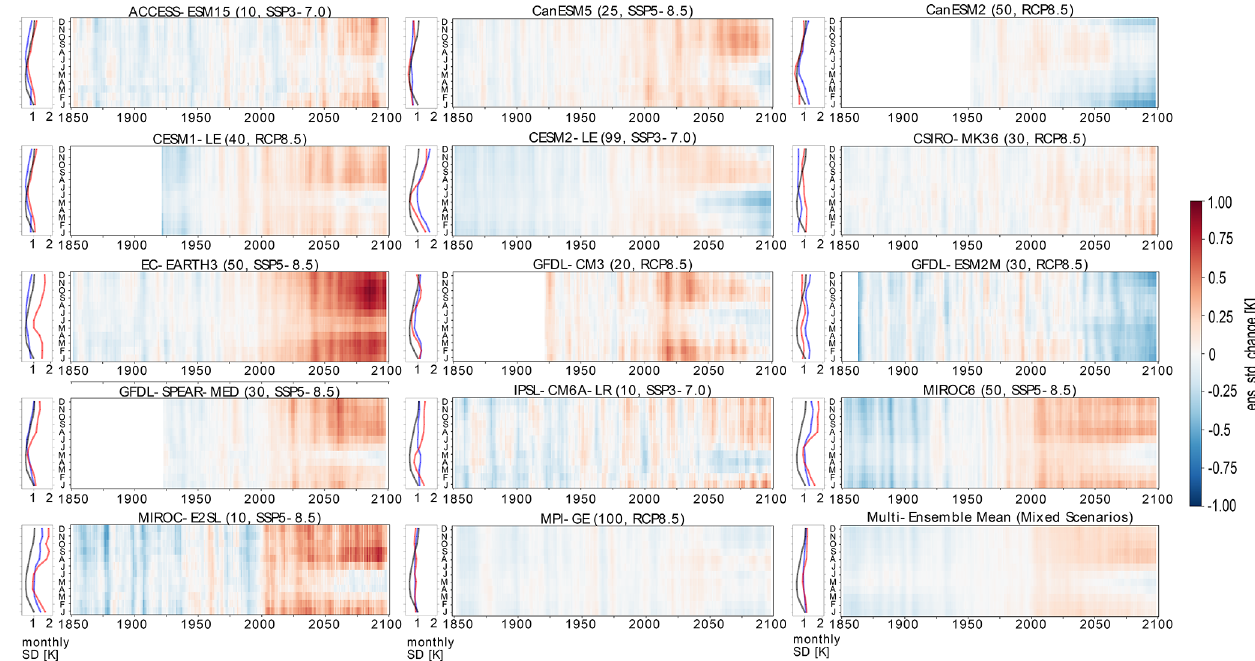
Figure 4. Change in ENSO SST variability, taken as the ensemble standard deviation in the Niño3.4 region for each SMILE and the multi-ensemble mean. Blue lines show the climatology in 1951–1980, shading shows the 5-year running-mean anomalies with respect to 1951–1980, and red lines show the climatology in 2070–2099. Black lines show the observational climatology based on ERSST5 in the period 1951–1980. We note that the climatology is computed as 1970–1999 for EC-Earth in blue and will be updated upon